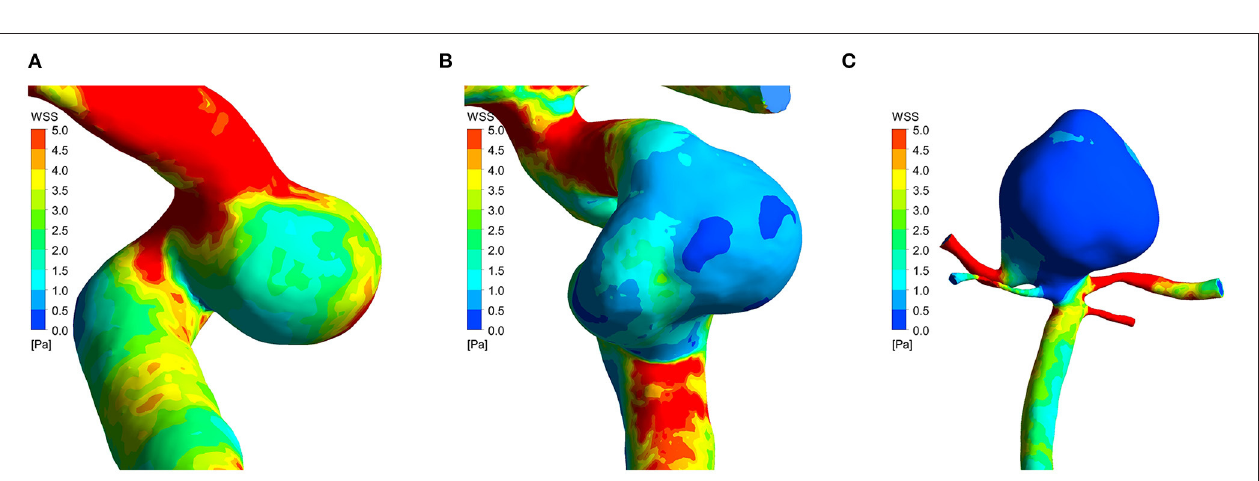
FIGURE 1 | The values of aneurysmal time-averaged wall shear stress (WSSa) (A) and normalized WSS (WSSn) (B) in the low-, intermediate-, and high-risk groups.